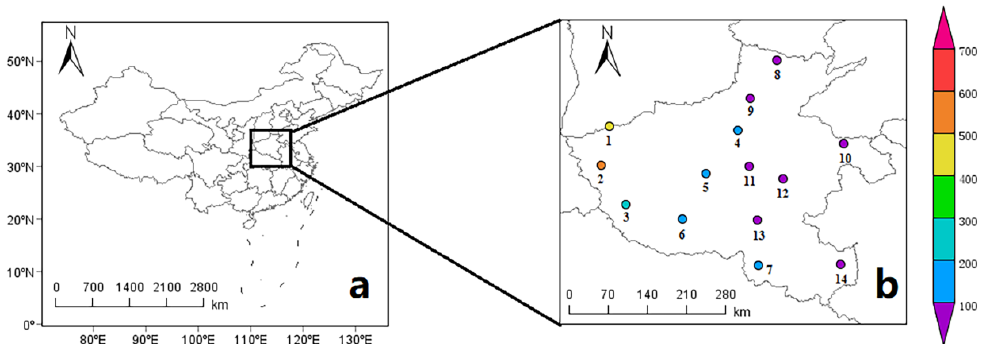
Figure 1. ( a ) The location of Henan province in China; ( b ) locations of weather stations in Henan Province (the color represents the height of each station). These stations were divided into three parts: western part (elevation > 200 m), central part (200 m > elevation > 100 m), and eastern part (elevation < 100 m) (Table 1). Table 1. The meteorological parameters (daily average value) of each station in Henan Province.